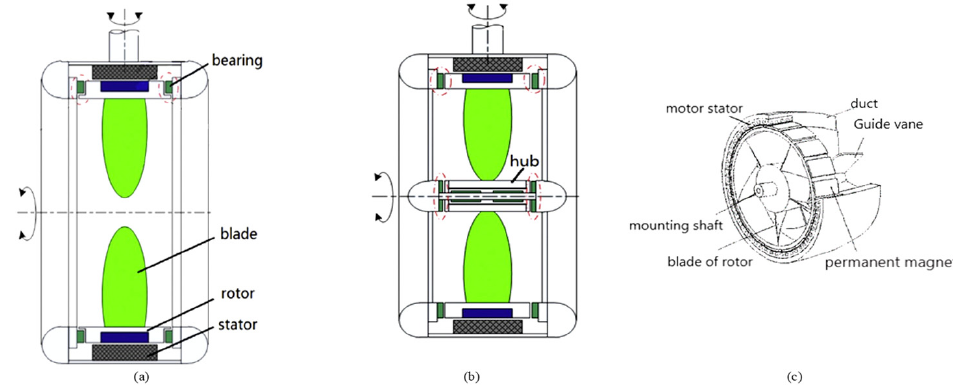
Figure 2. Structural diagrams of ( a ) hubless RDT, ( b ) hub-type RDT, and ( c ) hub-type IMP [3,4].